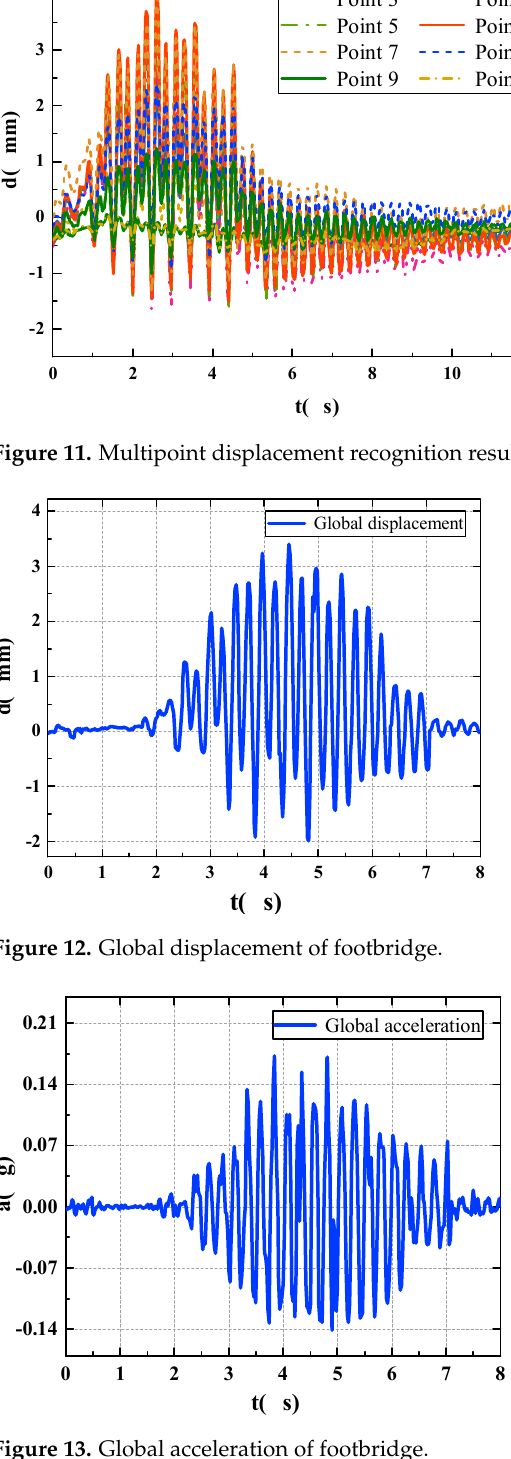
Figure 13. Global acceleration of footbridge.